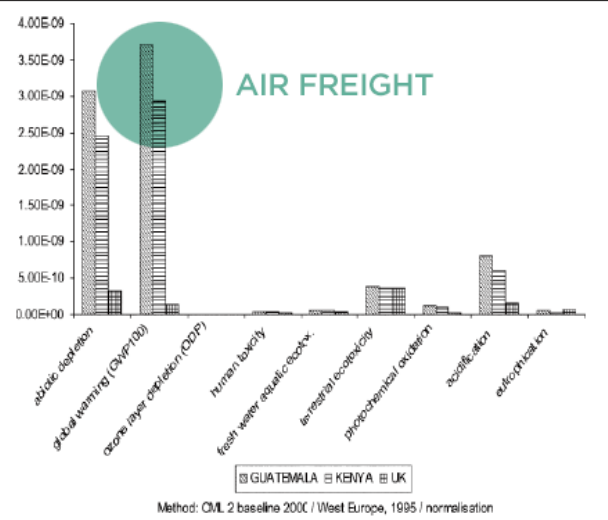
Figure 14: Comparison of impacts of air freighted vs. locally produced food. Source: Sim. (2007).